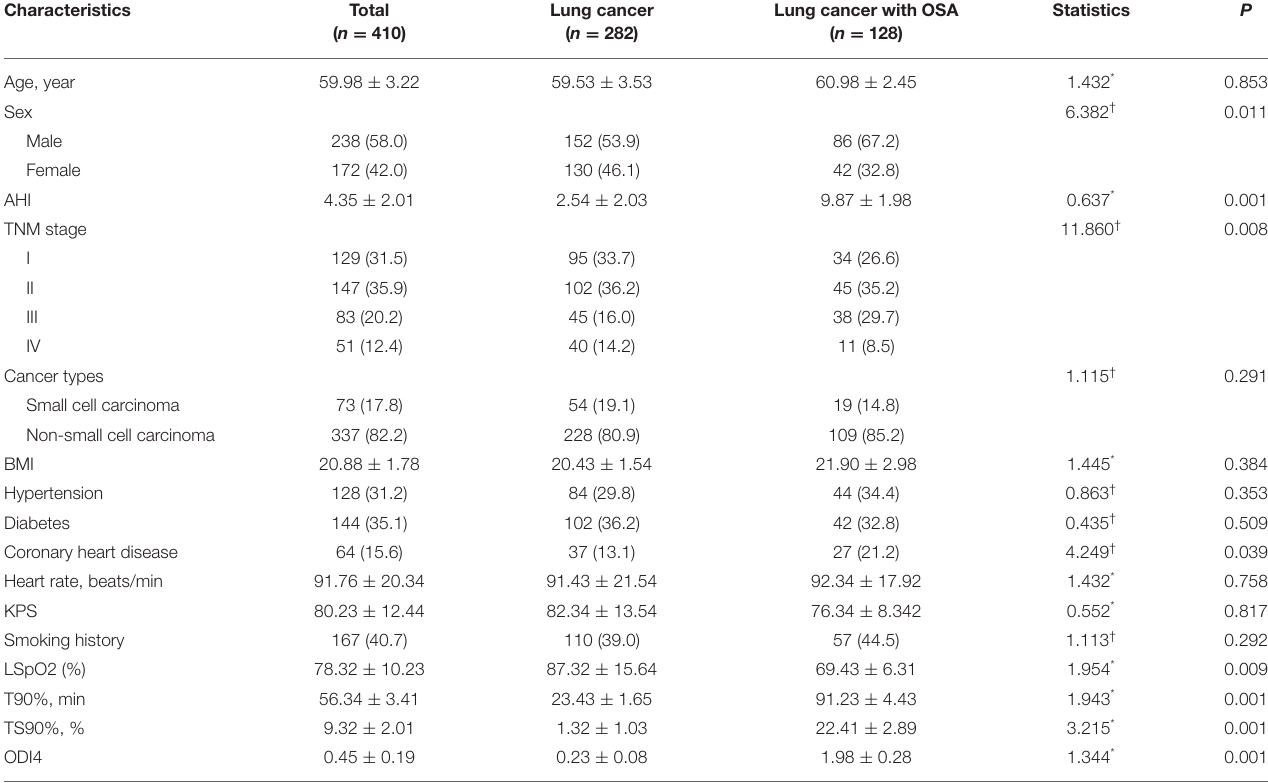
TABLE 1 | Baseline clinical features of all patients [Mean ± SD/No (%)].